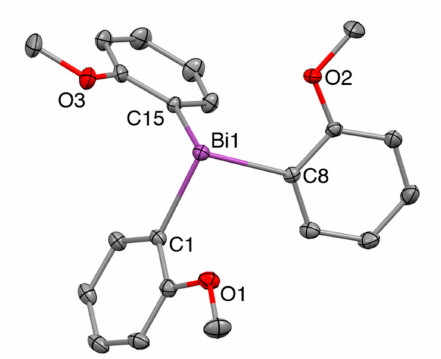
Figure 4. Packing of Tris(2-Methoxyphenyl)Bismuthine, in the solid state, ( left ): space group P2(1) / c, viewed along b-axis, one independent molecule per asymmetric unit, ( right ): space group R3, viewed along c-axis, two independent molecules per asymmetric unit, Bi2 is located on threefold axis.